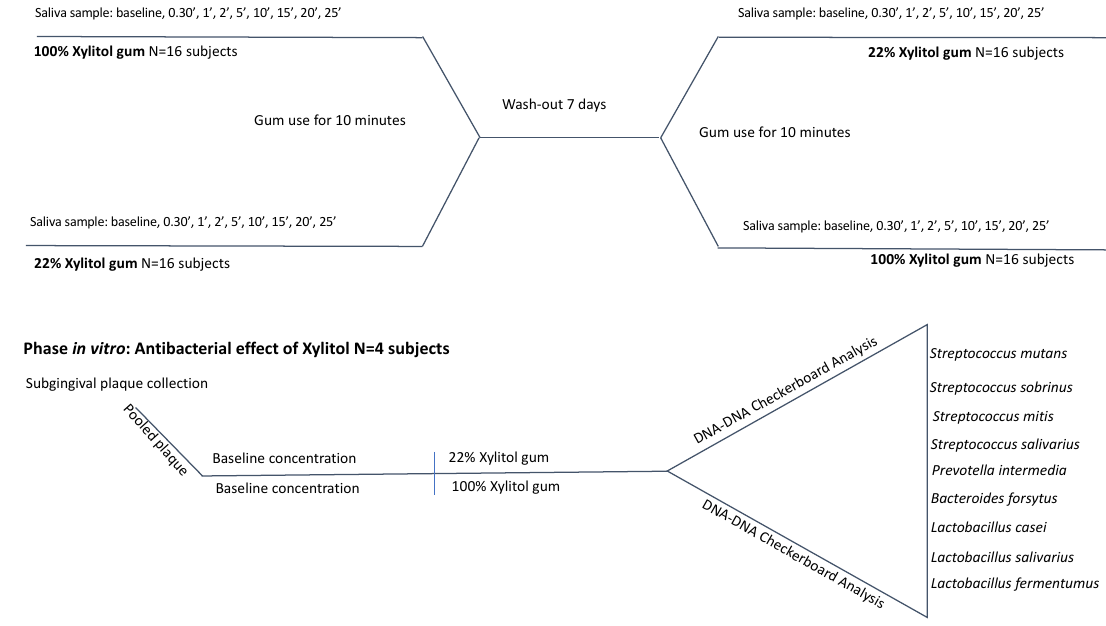
Table 1. Percentage Composition of the two chewing gums. Each chewing gum weights